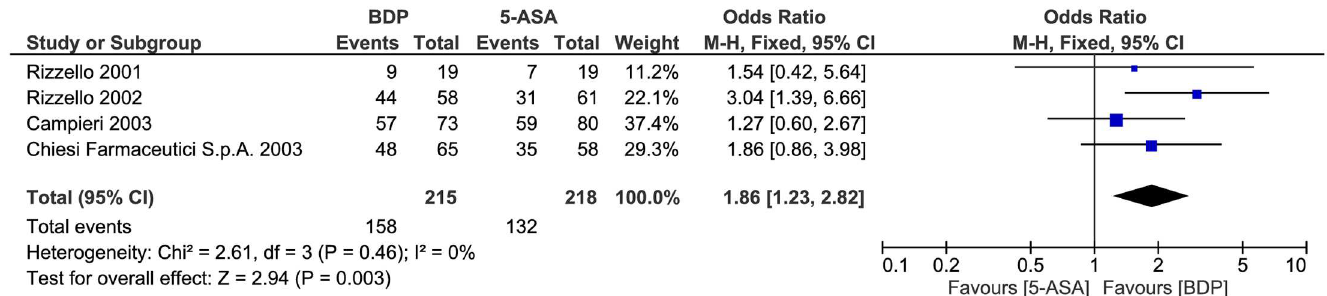
Fig 6. Forest plot of randomized controlled trials of oral BDP vs. oral 5-ASA in inducing clinical response in ulcerative colitis. BDP, beclomethasone dipropionate. 5-ASA, mesalazine.M-H, Mantel-Haenszel.